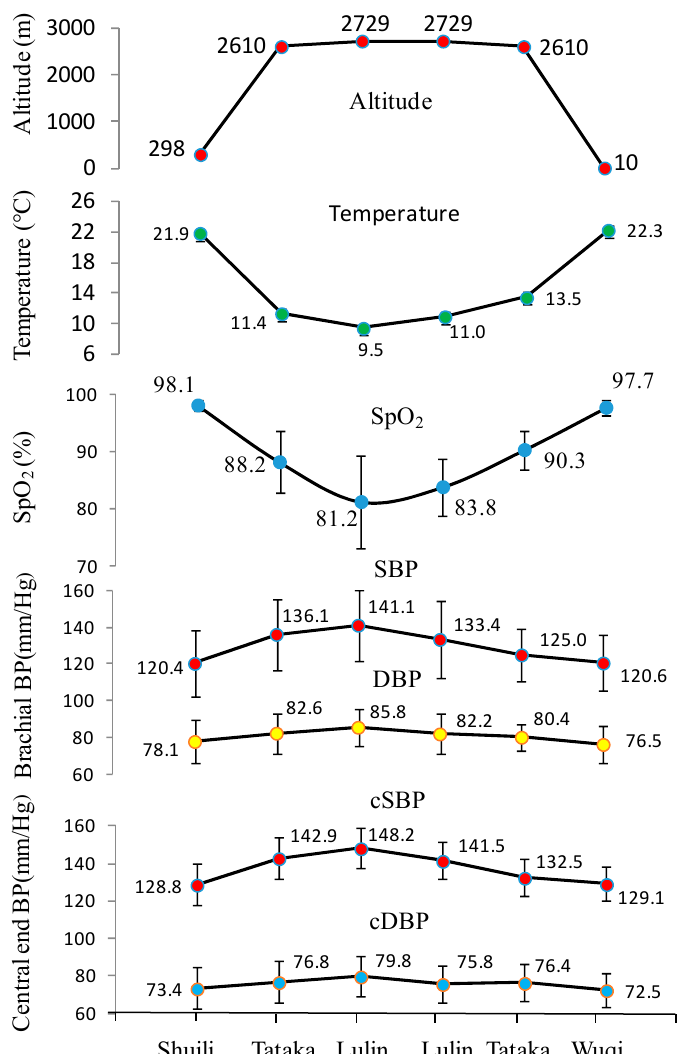
Figure 3. Variational comparison of the oxygen saturation rate and cardiac function after short-term exposure to high altitudes upon return to low altitudes.